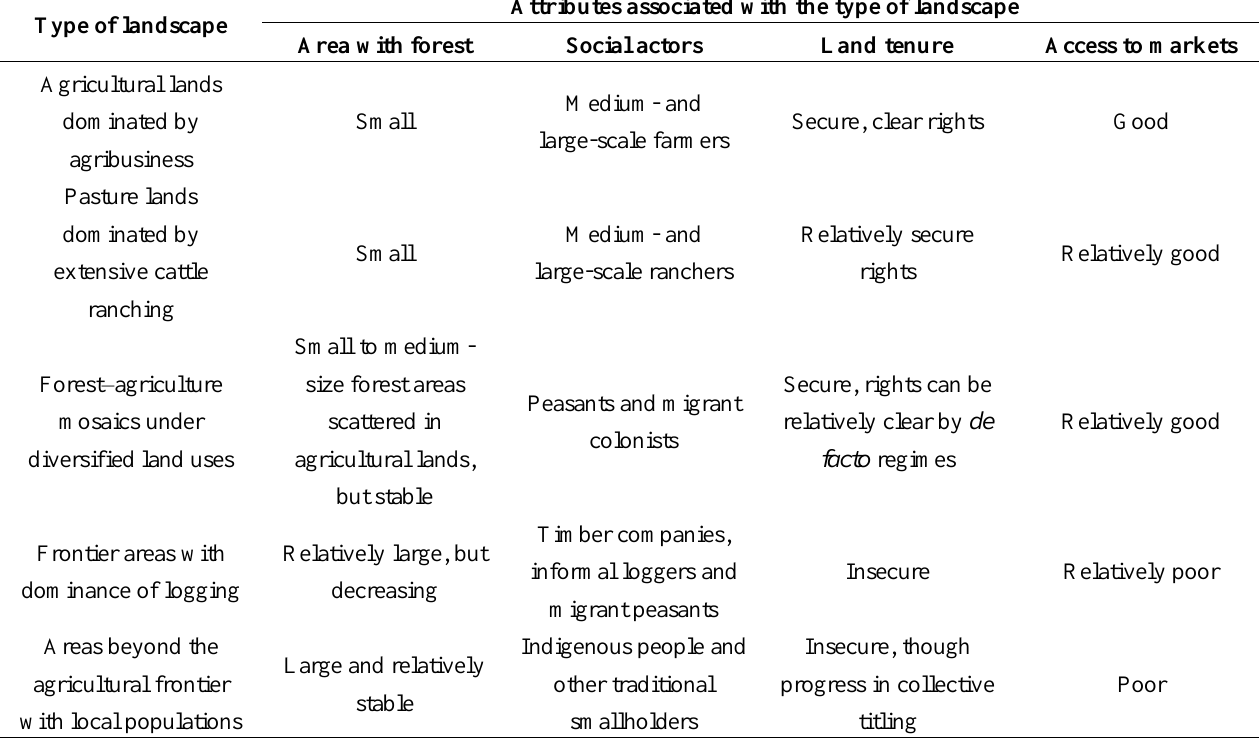
Table 2. Characteristics of stylized landscapes in tropical Latin